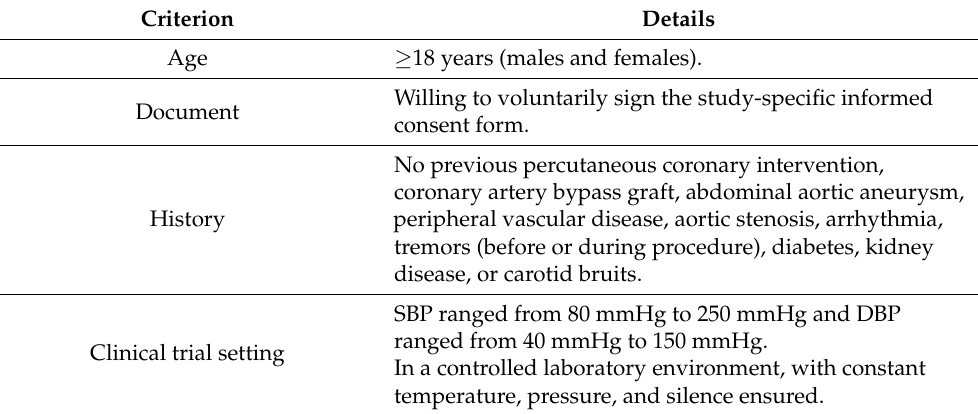
Table 1. The details of clinical trial database collection for BP estimation